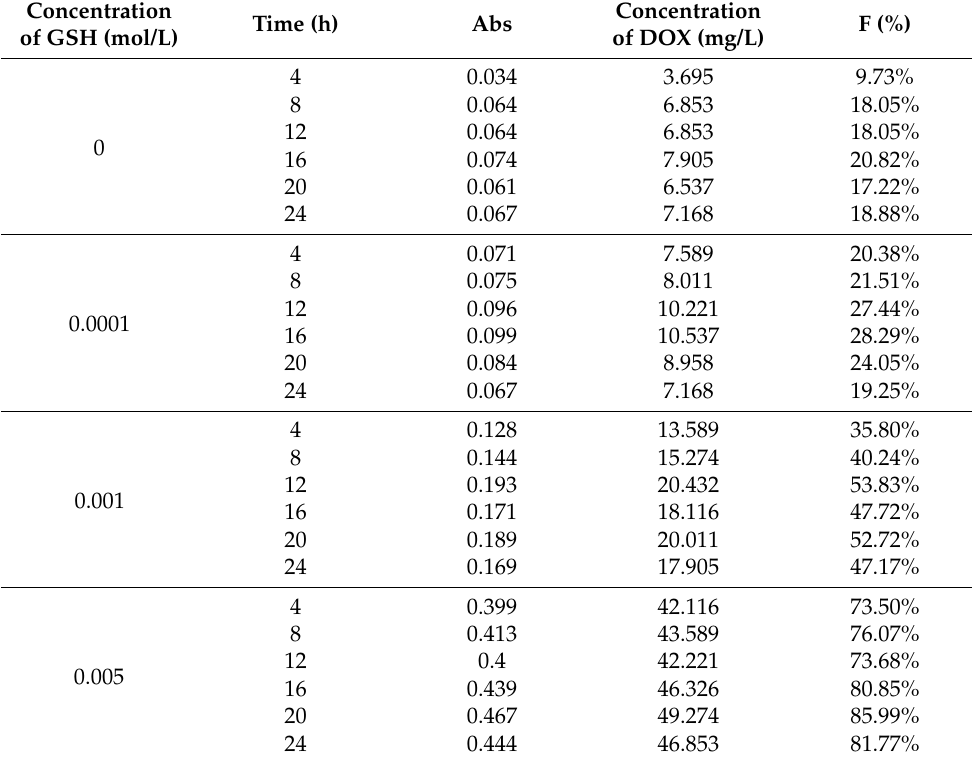
Table 1. Summary of drug release